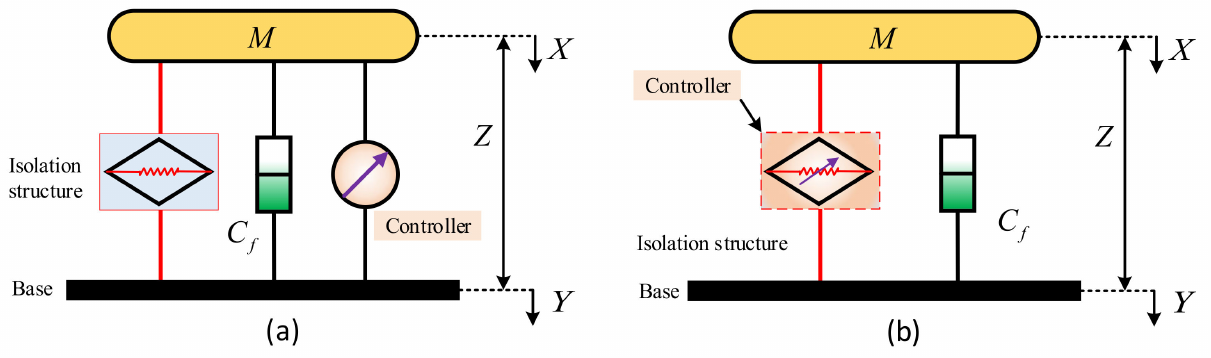
Figure 23. Schematic diagrams of typical active/semi-active QZS vibration isolation systems: ( a ) The controller is set outside the isolation structure; ( b ) the controller is set in the isolation